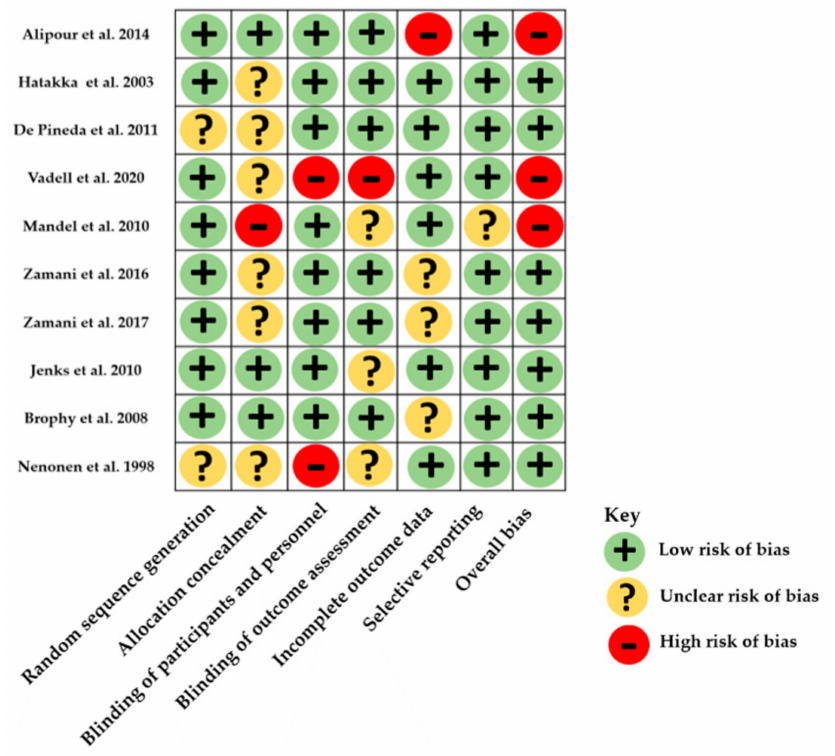
Figure 2. Distribution of risk-of-bias judgments within each bias domain of the Cochrane Collabora- tion